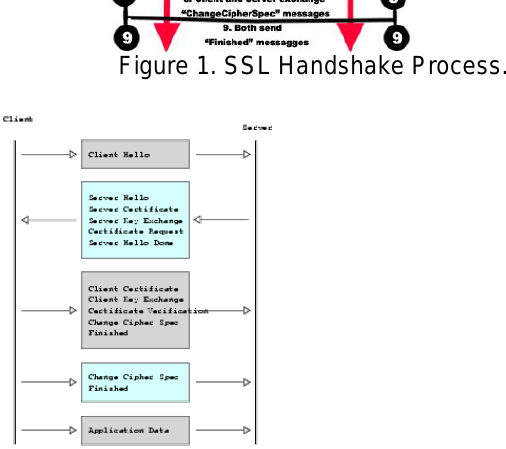
Figure 2. SSL Handshake